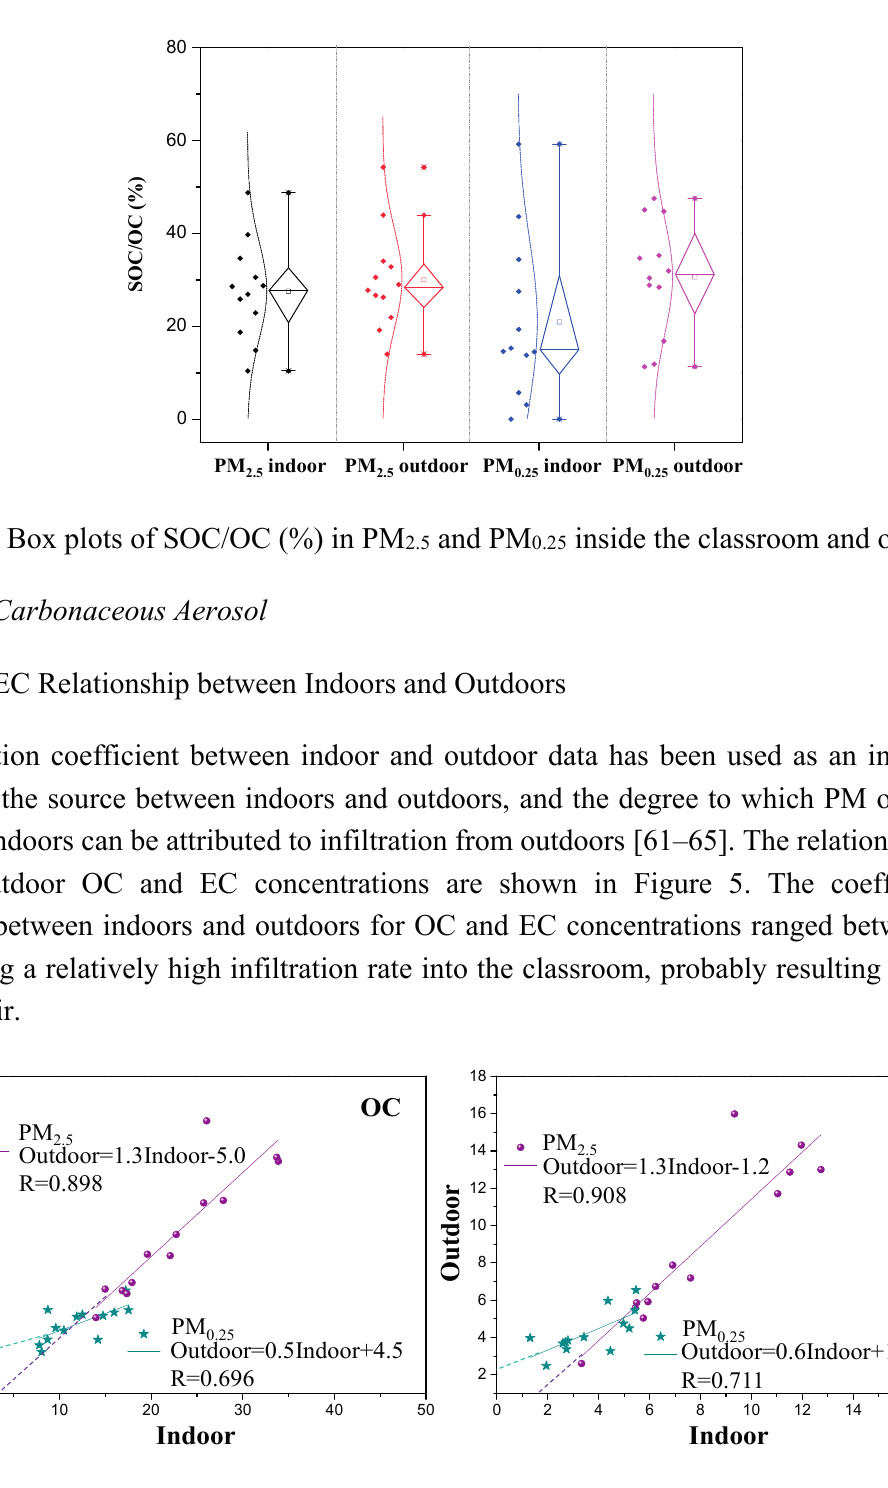
Figure 5. Indoor and outdoor comparisons of OC and EC mass concentrations in PM 2.5 and PM 0.25